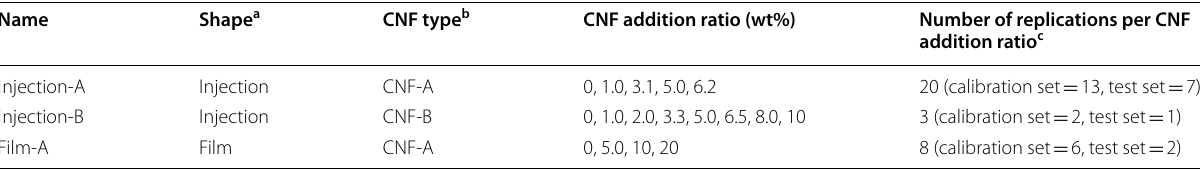
Table 1 The details of sample conditions: sample name, sample shape, cellulose nanofibril (CNF) types, CNF addition ratios, and number of